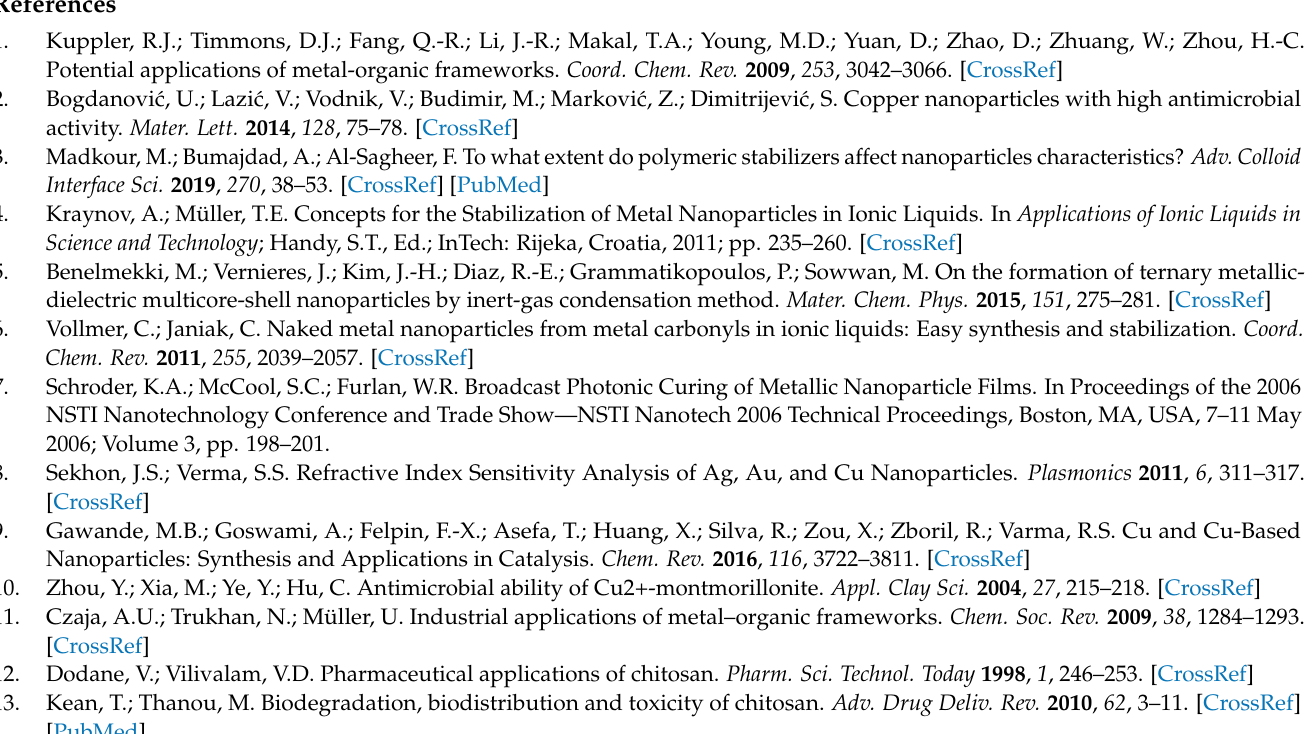
Table S1: Characteristics of the photoelectron spectra: binding energies (E b ), Gaussian widths (W), and relative intensities (I rel ) of photoelectron peaks belonging to different chemical groups in the C 1s and N 1s spectra; Table S2: FTIR-spectral characteristics of the initial chitosan and Cu/CS composites (low molecular weight chitosan, molar ratio Cu/CS = 1/10); Table S3: Elemental analysis of Cu/CS spherical composites (high molecular weight chitosan, 0.116 m, 300 µ L) data; Table S4: XPS quantification data (at.%) determined from the survey spectra; Table S5: Masses of Cu/CS freeze-dried spheres with a different volume of chitosan added and amounts of Cu absorbed in each one. References from Supplementary materials